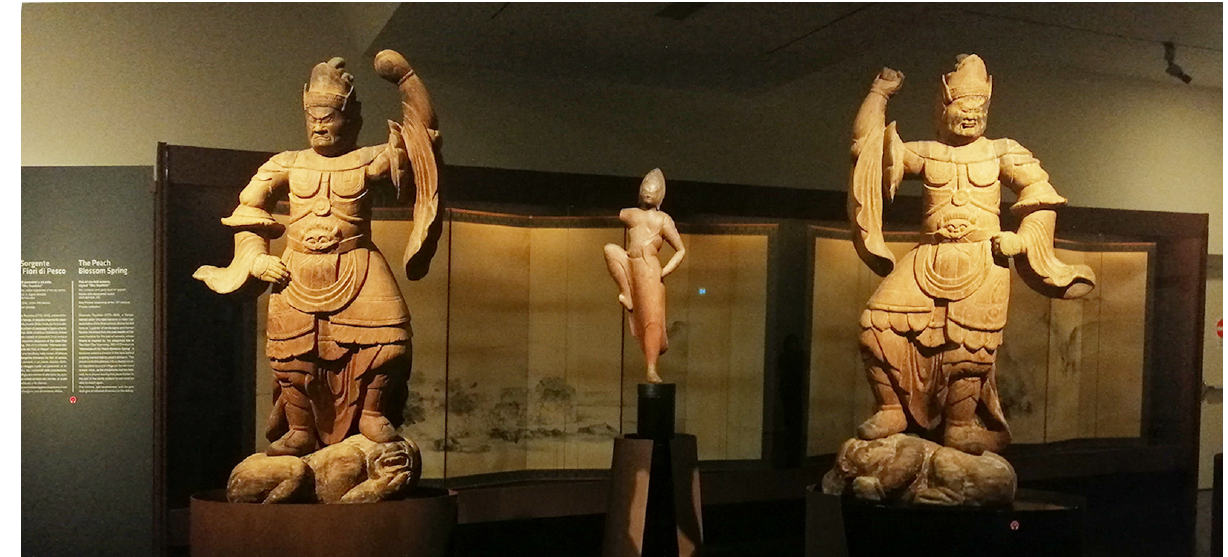
Figure 1 . The Ni-Tennō at the MAO Oriental Art Museum in Turin. Photo: F.